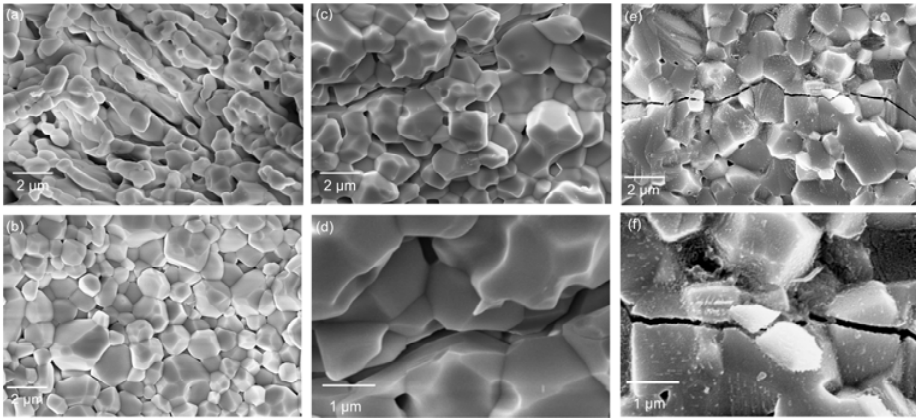
Figure 9. SEM images of y tt ria ceramics after thermal shock test: ( a ) sample 1#, CS; ( b ) sample 1#, SPS; ( c , d ) sample 2#, CS; ( e , f ) sample 2#,